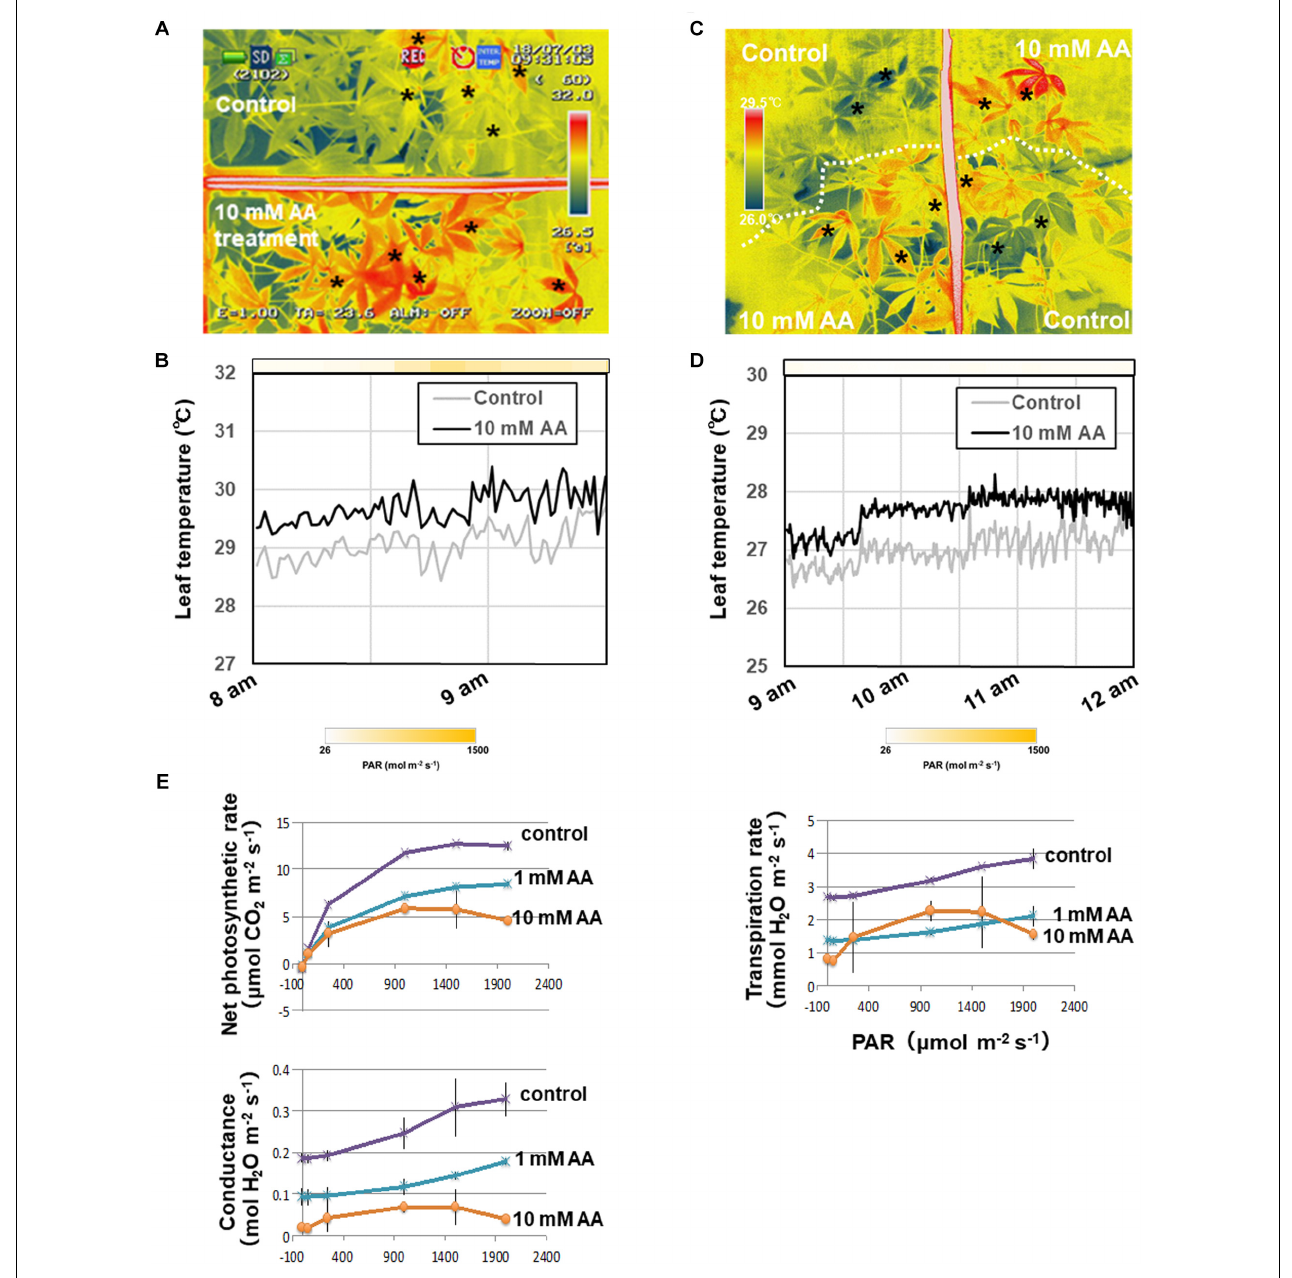
FIGURE 4 | Thermal images of whole plants and the net photosynthetic rate of cassava plants treated with either 10 mM acetic acid or water (control). (A) Thermal images of cassava plants treated with either 10 mM acetic acid or water (control) after 3 days under sunlight. (B) Leaf temperature differences in cassava plants treated with either 10 mM acetic acid or water (control) and placed in the sunlight. The mean leaf temperature was calculated based on temperature of five places on each leaf indicated by asterisks in (A) . The color gradation on the bar indicates the photosynthetically active radiation (PAR). (C) Thermal images of cassava plants treated with either 10 mM acetic acid or water (control) after 5 days under the cloudy condition. (D) Differences in leaf temperature of cassava plants treated with either 10 mM acetic acid or water (control) and placed under the cloudy condition. The mean leaf temperature was calculated based on the temperature of five places on each leaf indicated by asterisks in (C) . The color gradation on the bar indicates the PAR. (E) Net photosynthetic rate, stomatal conductance and transpiration rate of first to third leaves from the top of the stem of cassava plants treated with 10 mM acetic acid or water (control) at 7 days after the commencement of the drought. Mean ± SD of nine leaves from three